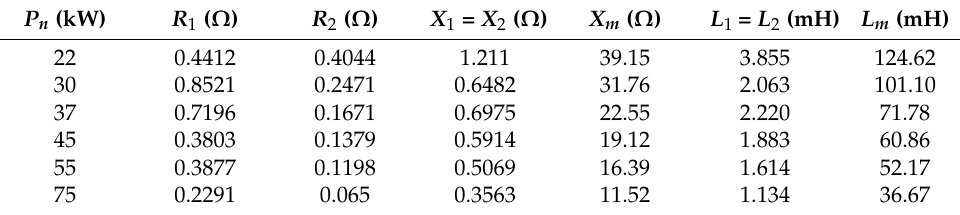
Table 4. Parameters of Thevenin equivalent